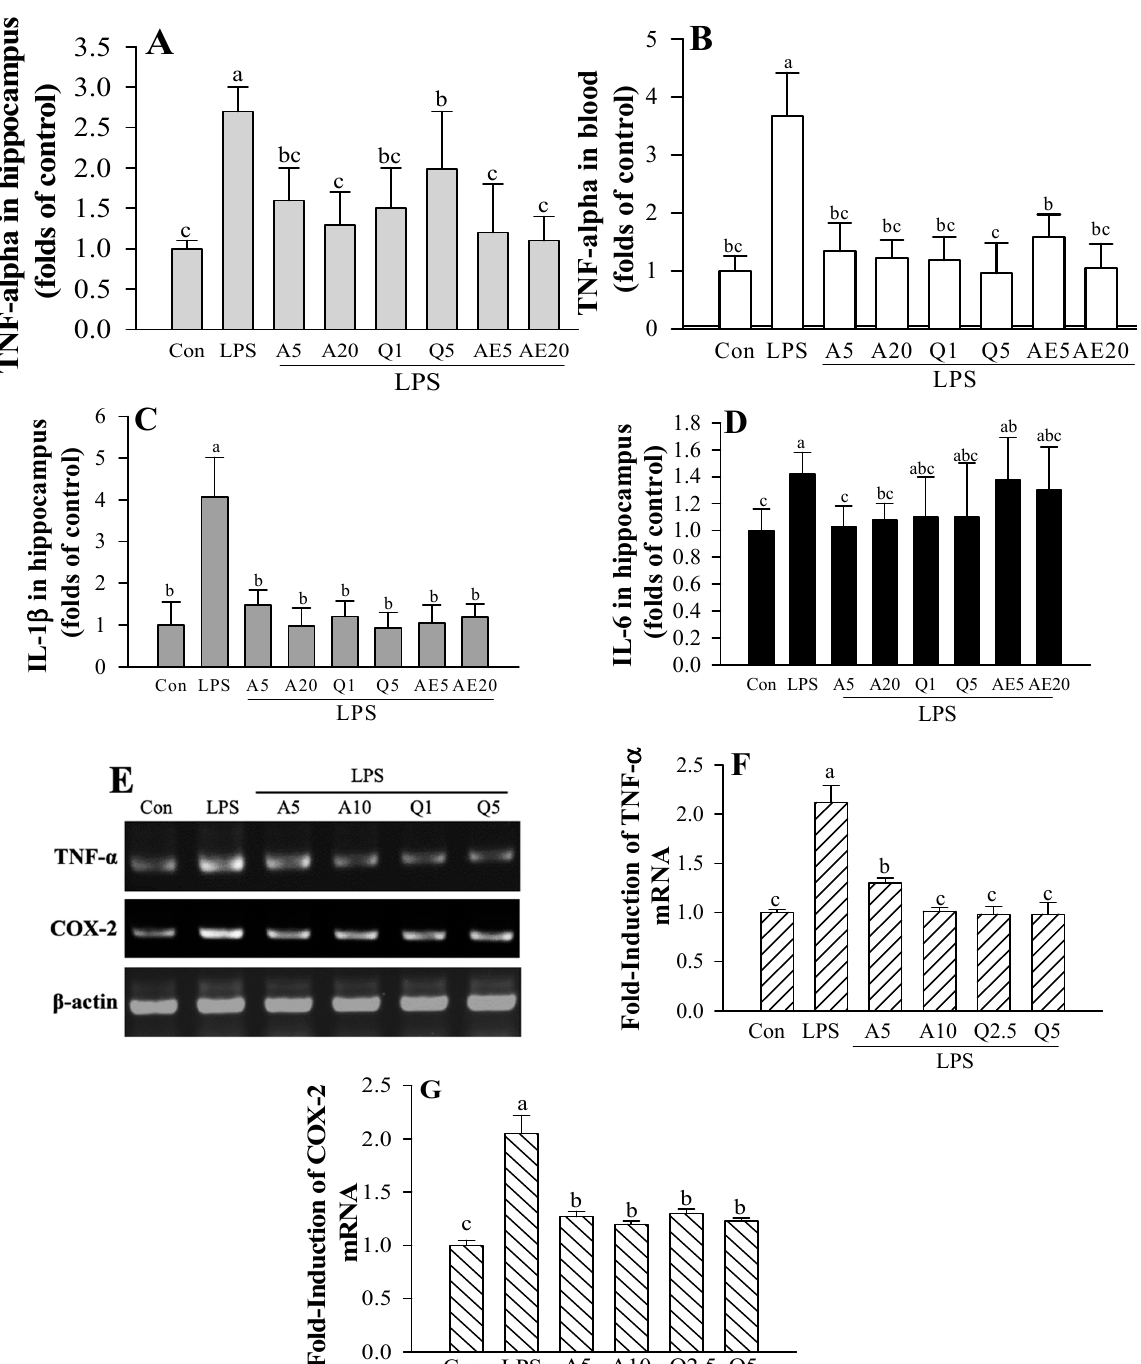
Figure 9. Effect of Ast (A) and Que (Q) on pro-inflammatory cytokines and COX-2 in blood and the hippocampus of LPS induced mice. ( A , C , D ) protein levels of TNF- α , IL-1 β and IL-6 in the hippocampus of LPS-induced mice. ( B ) protein levels of TNF- α in the blood of LPS-induced mice. ( E – G ) TNF- α and COX-2 mRNA in the hippocampus of LPS-induced mice. Con, control: LPS- and sample-untreated cells; Group LPS: cell treated with LPS only. Housekeeping gene β -actin level was used for normalization of the mRNA levels in each sample, and the density of each ( E – G ) mRNA band was quantified by using SigmaGel software. The values shown are the mean ± SD ( n = 6) and means labelled with different letters (a–c) within a property differ significantly as determined by Duncan’s multiple range test ( p < 0.05).